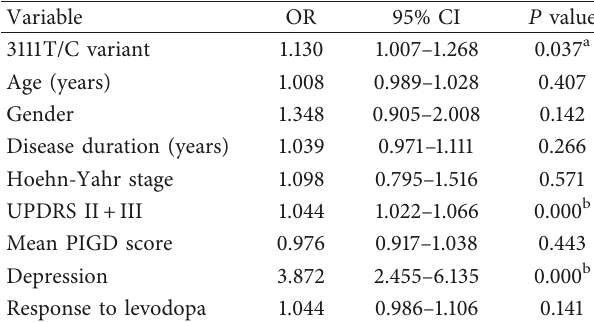
Table 3: Binary logistic regression of association between sleep disorders and CLOCK 3111T/C